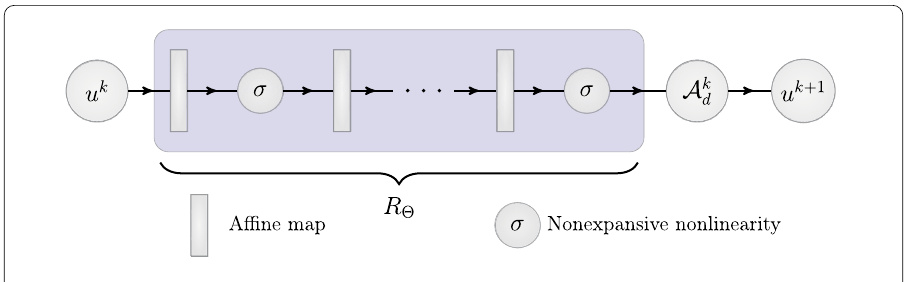
Figure 1 Diagram for update operations in the learned fixed point iteration (L-FPI) to solve (L-CFP). Here R (cid:5) is comprised of a finite sequence of applications of (possibly) distinct affine mappings ( e.g. convolutions) and nonlinearities ( e.g. projections on the nonnegative orthant i.e. ReLUs). For each k ∈ N , we let A k projection-based algorithmic operator. The parameters (cid:5) of R (cid:5) are tuned in an offline process by solving (9) to ensure signals are faithfully